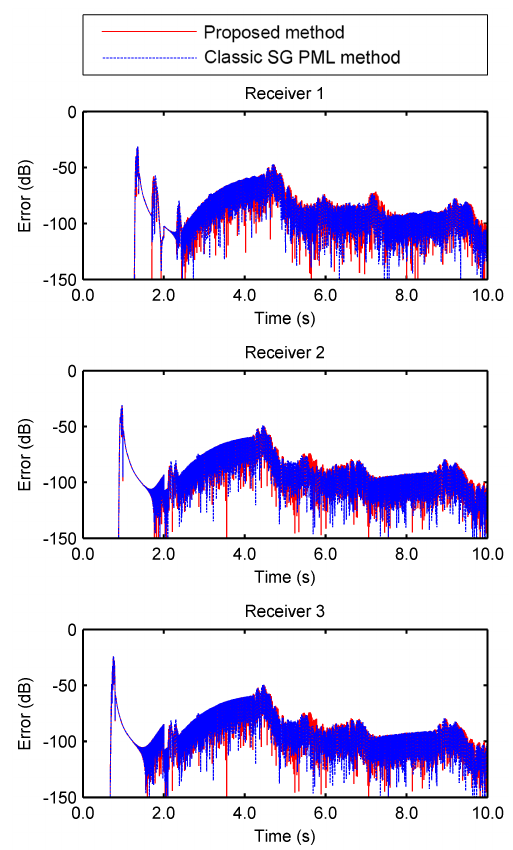
Figure 10. Comparison of the relative errors between the analytical solutions and the proposed method (10th-order CG scheme) (red solid line) or the classic SG PML method (10th-order SG scheme) (blue dotted line) at different receivers and different grid spacings ( d = 10m, receivers 1, 2, and 3).